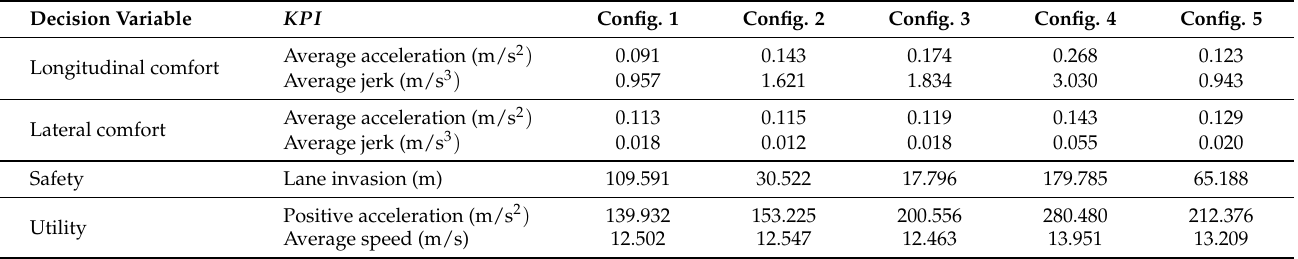
Table 6. Key performance indicators obtained in the simulation environment.